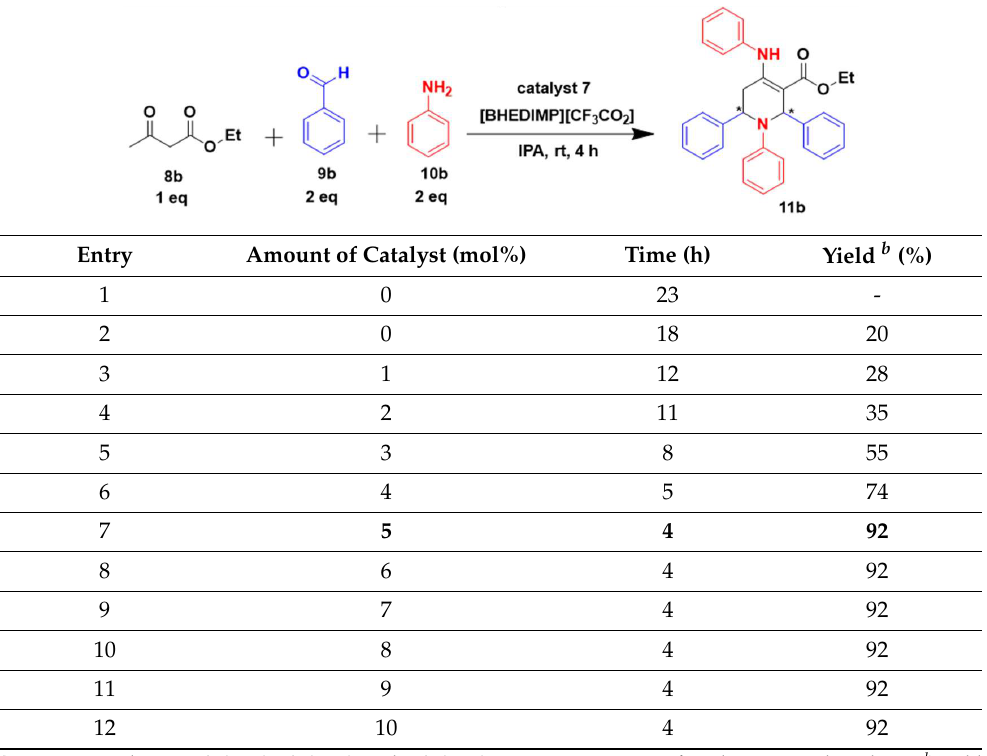
Table 2. Optimization of catalyst for THP derivatives a .